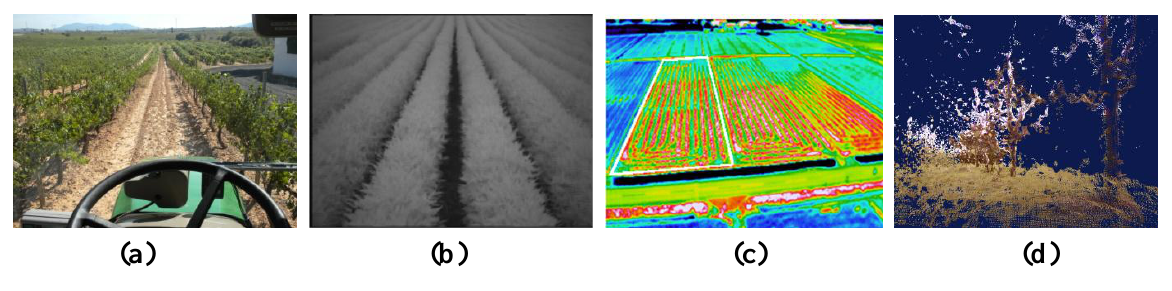
Figure 6. Typical images used in agricultural robotics : (a) RGB color image. (b) NIR-filtered monochrome image. (c) Thermographic map (Courtesy of N. Noguchi). (d) Stereoscopic